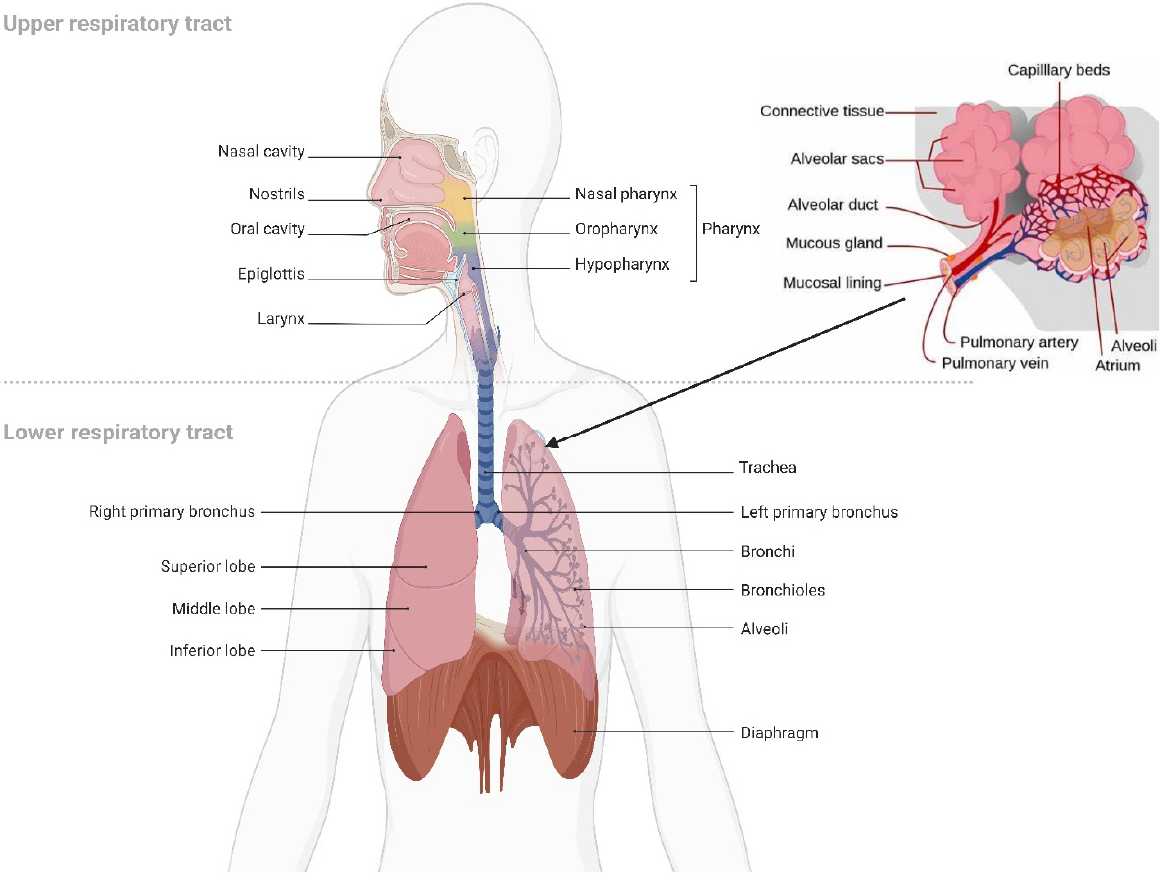
Figure 7. Human upper and lower respiratory